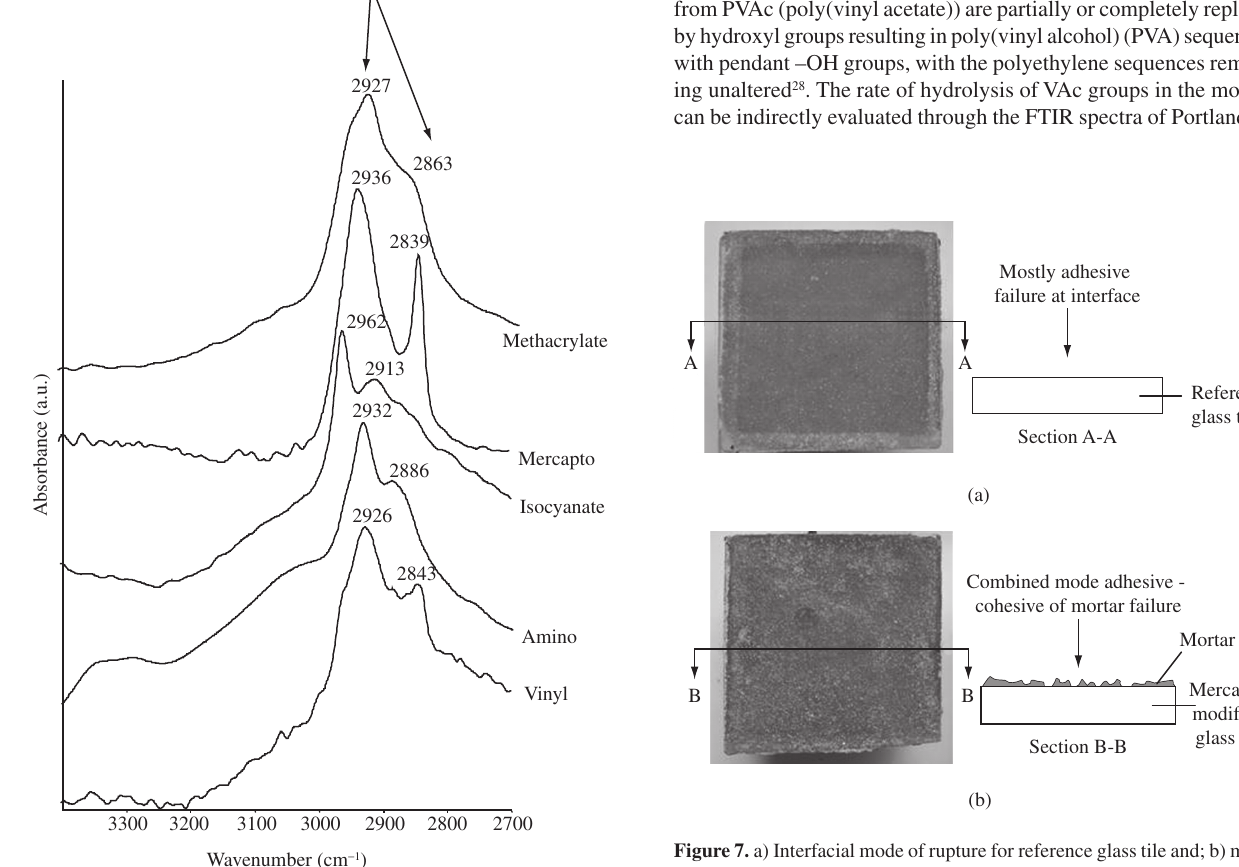
Figure 7. a) Interfacial mode of rupture for reference glass tile and; b) mixed mode interfacial-cohesive of the mortar due to mercaptosilane glass tile